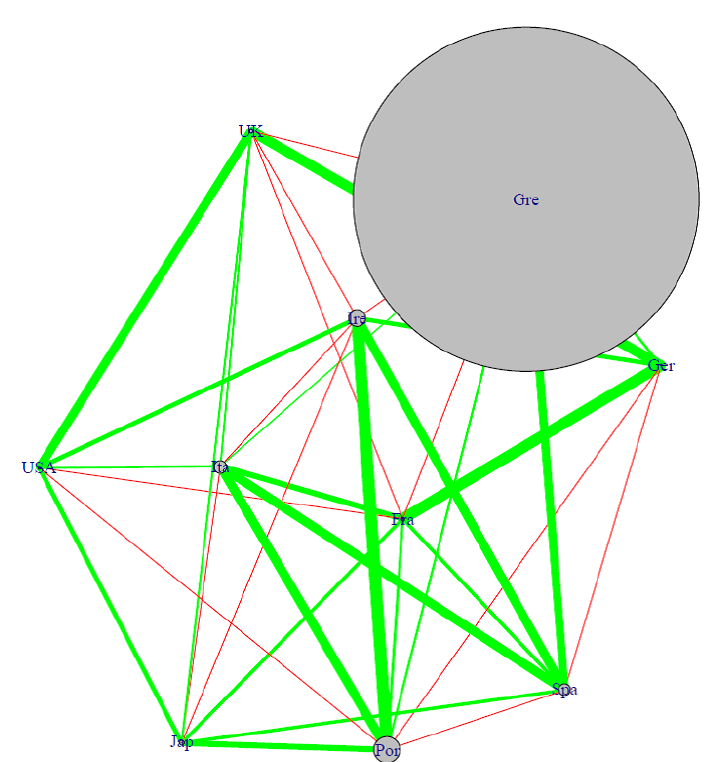
Figure 1. Partial correlation network referred to 10 countries: five core economies (France, Germany, Japan, the United Kingdom and the United State) and five peripheral economies (Greece, Ireland, Italy, Portugal and Spain). Green lines stand for positive partial correlations, red lines for negative correlations; the thicker the line, the stronger the connection; the larger a node, the higher the corresponding idiosyncratic probability of default. Table 2. Estimated partial correlations between contemporaneous country spread effects, and the corresponding significance t -test values (in parentheses). Bold values indicate not significant values at the 1% level.